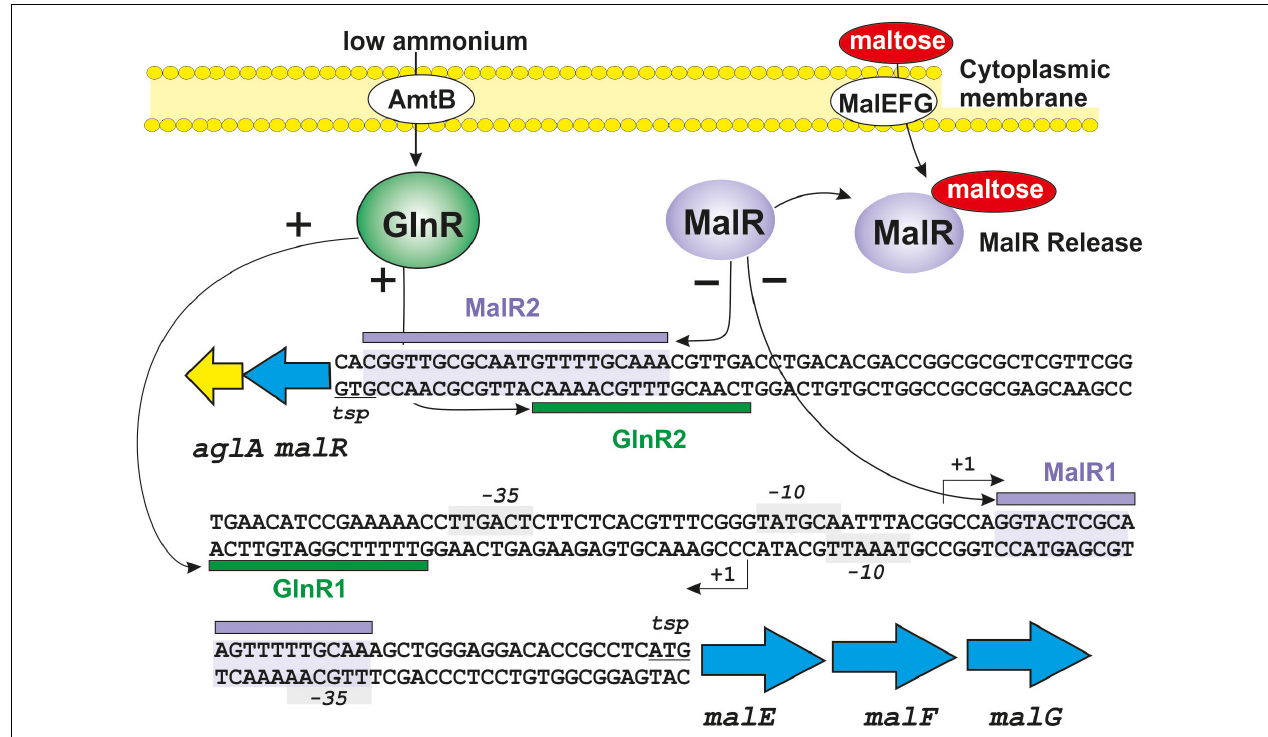
FIGURE 3 | Interaction between the repressor protein MalR and the activator protein GlnR on the mal operon of Sac. erythraea . The intergenic aglAmalR-malEFG region is shown with the MalR binding sites shadowed in purple. The binding sites for MalR and GlnR are indicated with purple and green horizontal bars, respectively. The -10 and -35 sites for both operons are shown in gray boxes. The +1 transcription sites and the translation starting points for both operons are indicated. Positive regulation is indicated by arrows and a ( + ) sign; negative regulation is indicated by arrows and a ( − ) sign. Maltose (red ellipse) induces the malEFG operon by binding to the MalR repressor and releasing it from the DNA. See text for additional